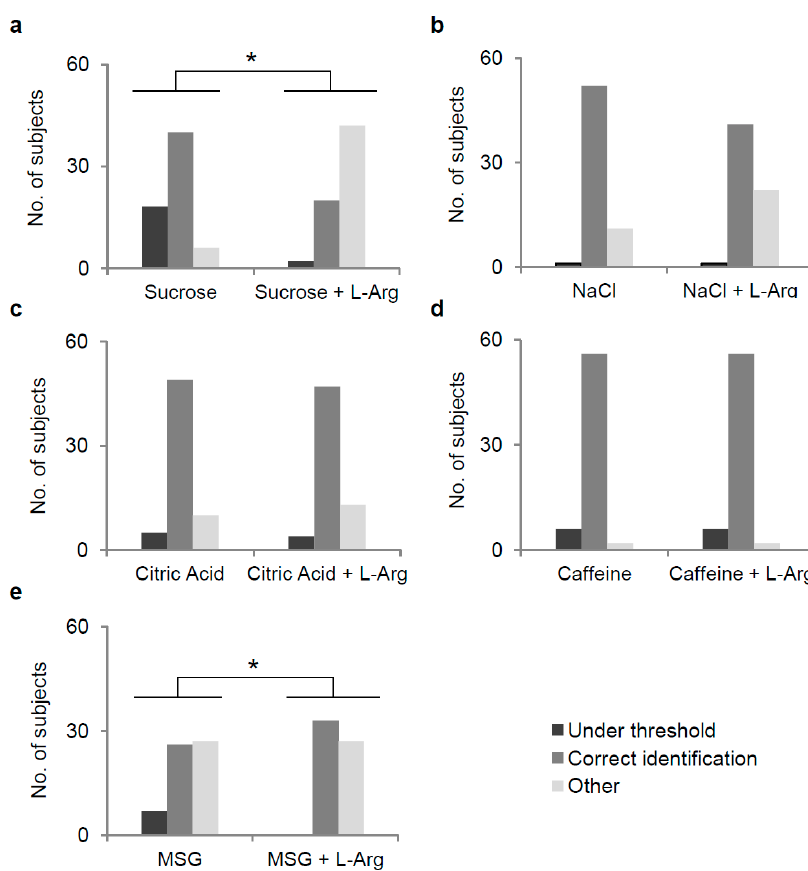
Figure 2. The number of subjects who perceived no taste, correctly recognized the taste, or described an incorrect taste response (Other) for the stimulus representative of each primary taste quality, presented at low concentration or supplemented with L -Arg (1:1 molar ratio L -Arg). n = 64. ( a ) Sucrose 20 mmol/L; ( b ) NaCl 20 mmol/L; ( c ) Citric acid 1.3 mmol/L; ( d ) Caffeine 1.5 mmol/L; and ( e ) MSG 10 mmol/L. * Significant difference ( p < 0.00001; Fisher’s exact).